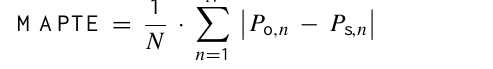
Fig. 3. Error surface of the Mean Absolute Peak Time Er- ror (MAPTE) for synthetic, triangular events as shown in Fig. 1. Simulations are shifted in time (offset range [ − 20h, 20h]) and am- plitude (multiplier range [0, 2]). The error surface is normalized to [0, 1] by means of division with the maximum